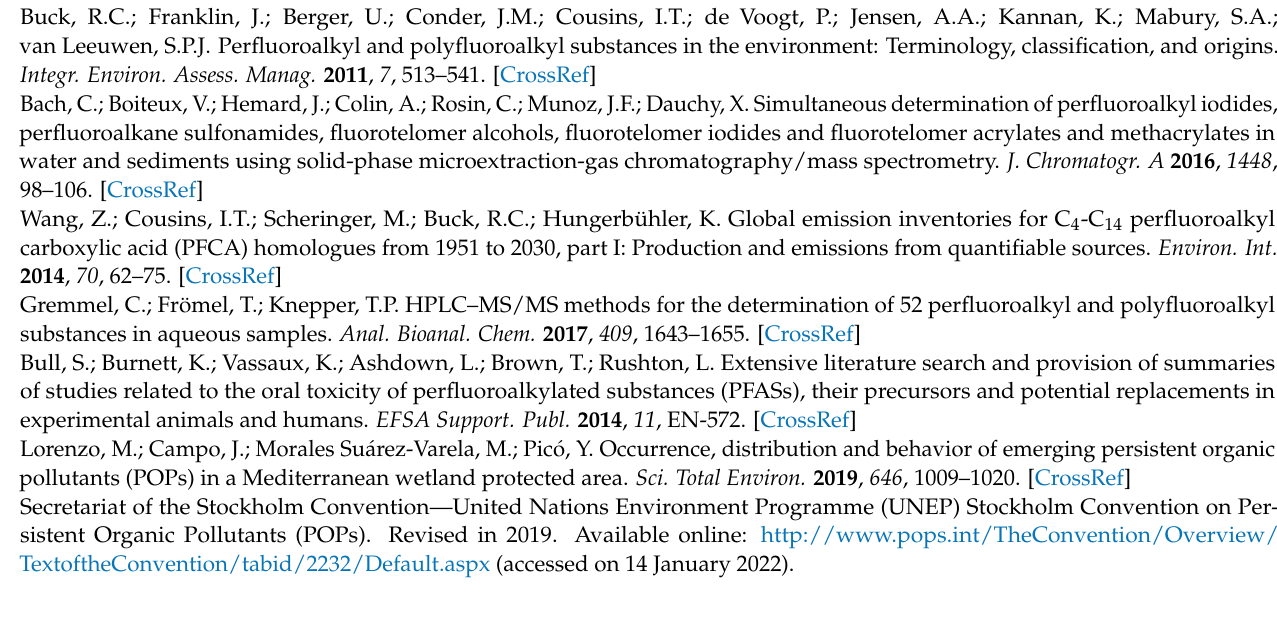
synthesized materials. Figure S3: Low-angle XRD patterns of the Fe50-UVM-7-C 12 material (a) before its use as a sorbent (reference) and (b) after being used five times for the extraction of PFASs from water